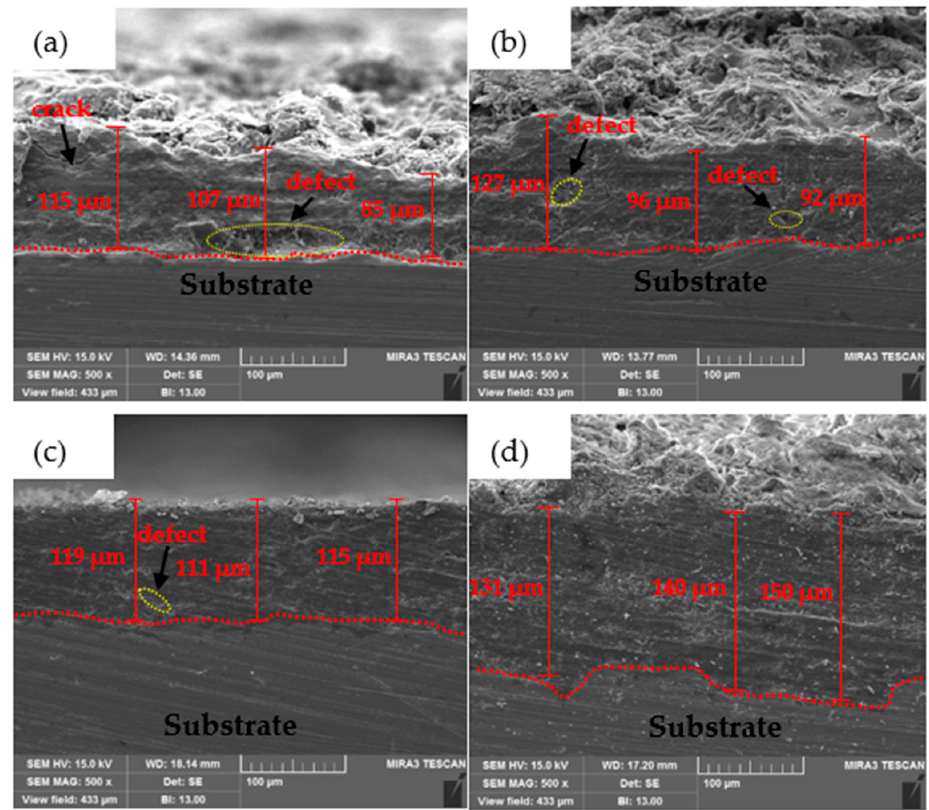
Figure 2. Cross sectional SEM of ( a ) AC, ( b ) SPCN1, ( c ) SPCN2, and ( d ) SPCN3. Table 1. Energy-dispersive X-ray spectroscopy (EDS) analysis of coatings. Elements (wt.%) Sample ID